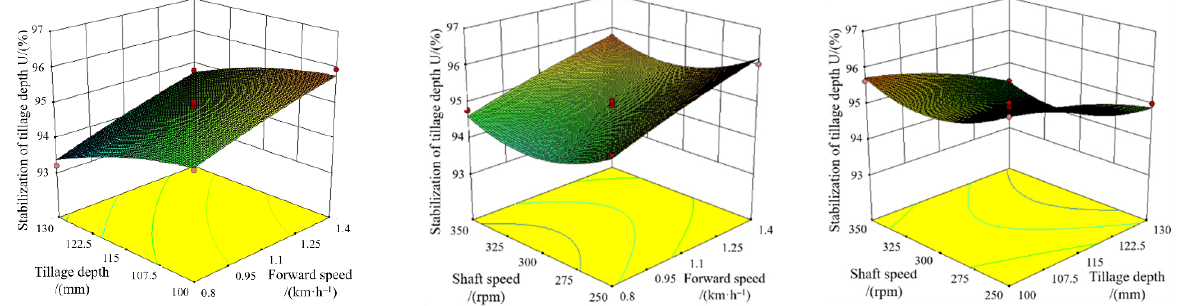
Figure 18. Response surface variation relationship influencing factors on the tillage depth stability.